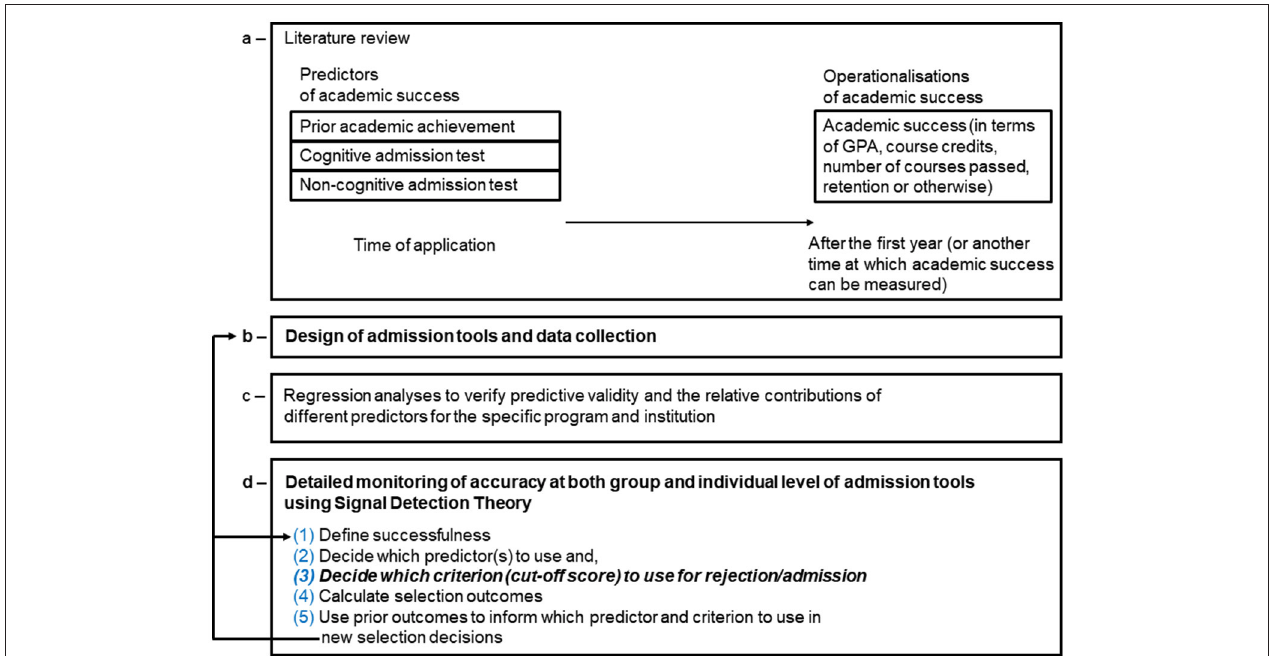
FIGURE 1 | Scheme of how regression analyses and Signal Detection Theory can—in general—be used to design admission tools and to monitor their accuracy across cohorts. a—The literature provides information on the validity of certain predictors for certain types of academic success. b—The findings from the literature inform decisions on program-specific admission tools, procedure, and data collection. c—Regression analyses show which model best explains academic success. d—Signal Detection Theory informs whether the model performs as expected from the regression analyses, adding information on sensitivity, specificity and selection outcomes depending on the application of specific criteria. The Signal Detection outcomes can be used in quality assurance of admission: it provides information on group level, the individual level and on the effects of specific criteria. It thus allows evaluation of the operationalization of academic success and the admission tools used. This, in turn, informs future data